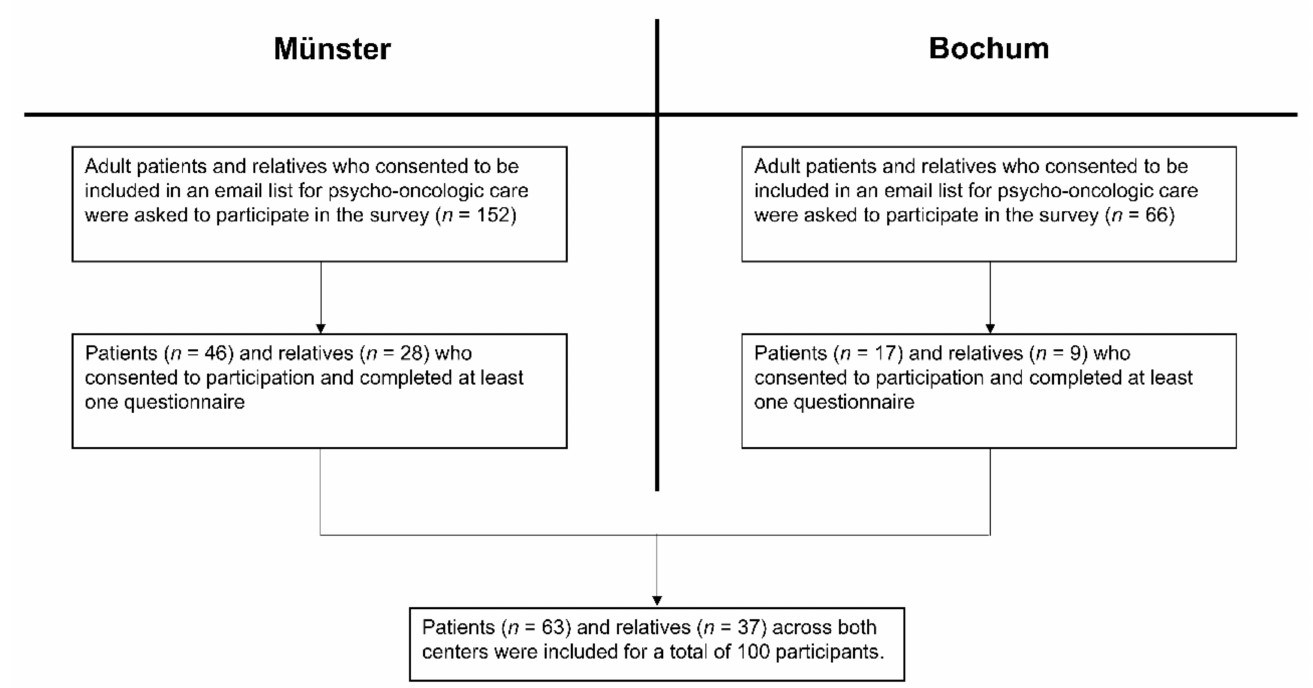
Figure 1. Participant inclusion, visualized for both